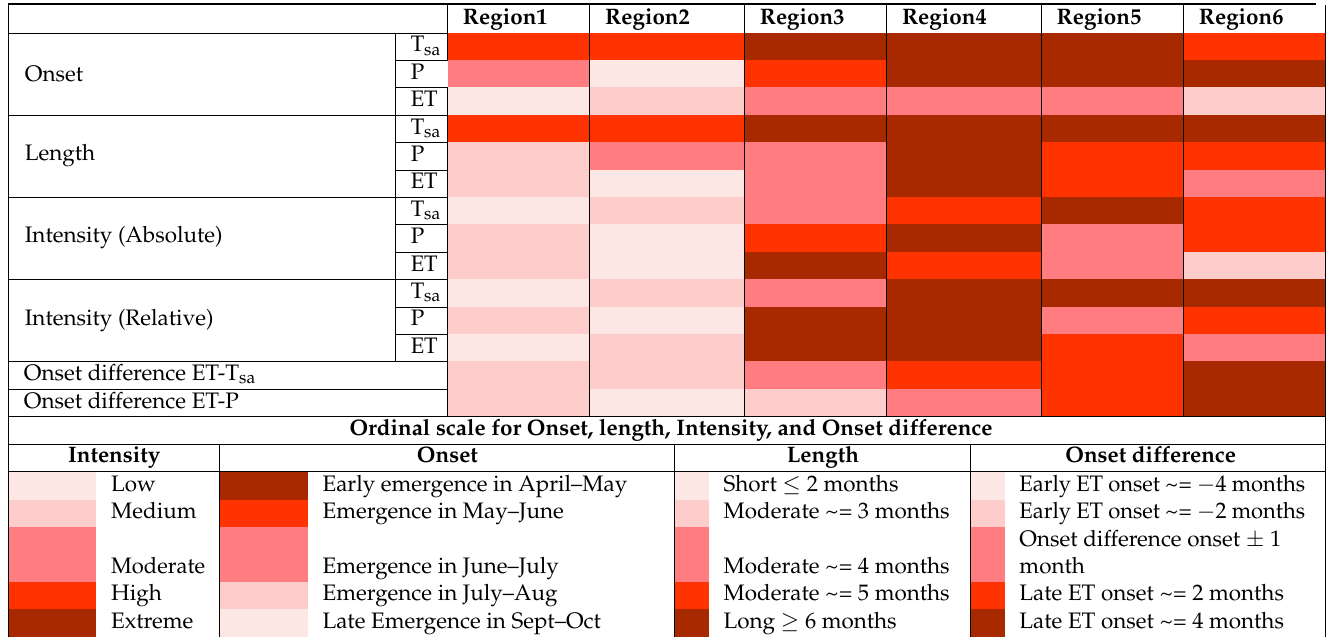
Table 2. Overview of drought characteristics for surface air temperature (T sa ), precipitation (P), and evapotranspiration (ET) for six selected regions distributed across